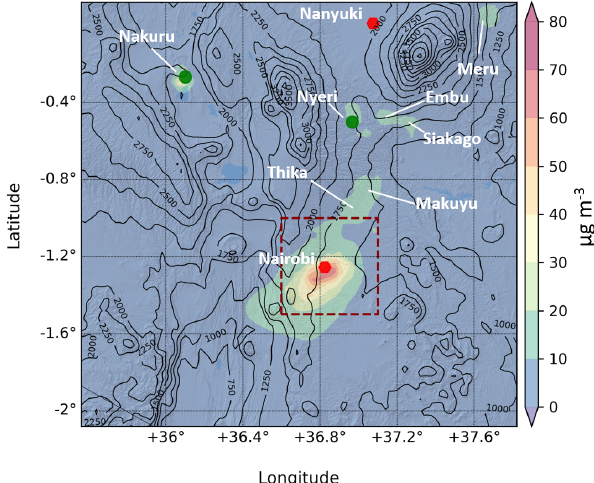
Figure 9. The average PM 2 . 5 concentration for the whole simulated period for the KEN2K domain at a 2 × 2km spatial resolution. The map shows the location of hotspots with higher average concen- trations, as modelled by CHIMERE, for the entire period. The red dashed square shows the urban domain of Nairobi analysed for the Air Quality Index analysis in Sect.